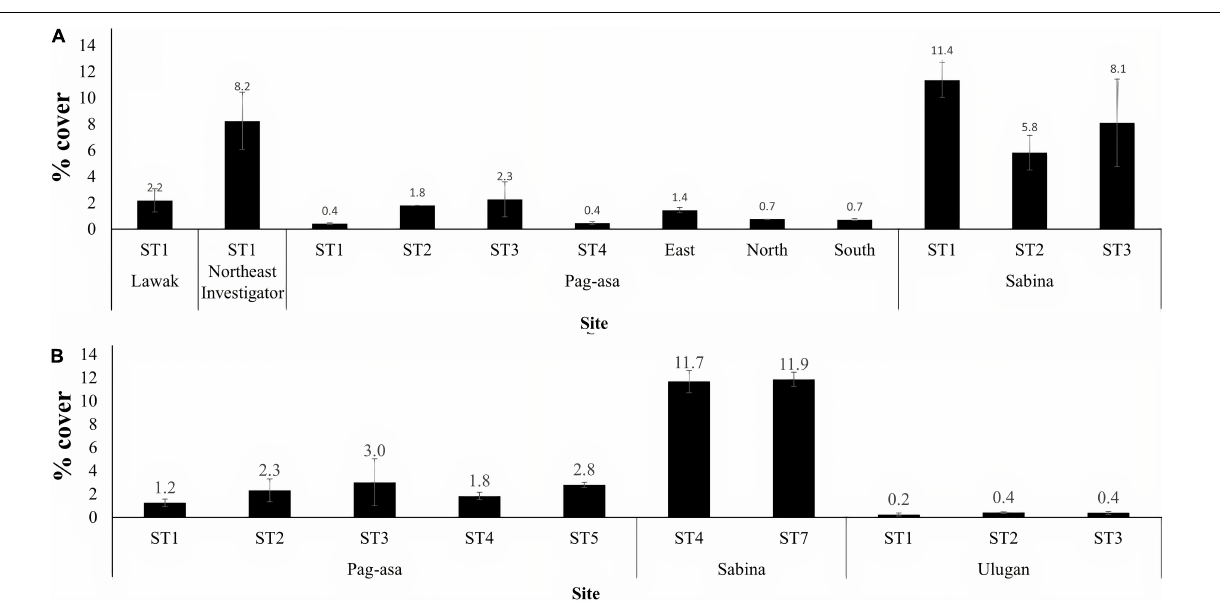
from the other sites due to higher abundance of nephtheids and holaxonians (dissimilarity contribution: > 20.00%), whereas Pag- asa differed from Ulugan due to higher abundance of helioporiids (dissimilarity contribution: 26.85%) ( Table 5